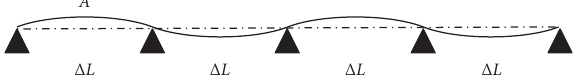
Figure 3: Profile deviation of a high-speed elevator guide